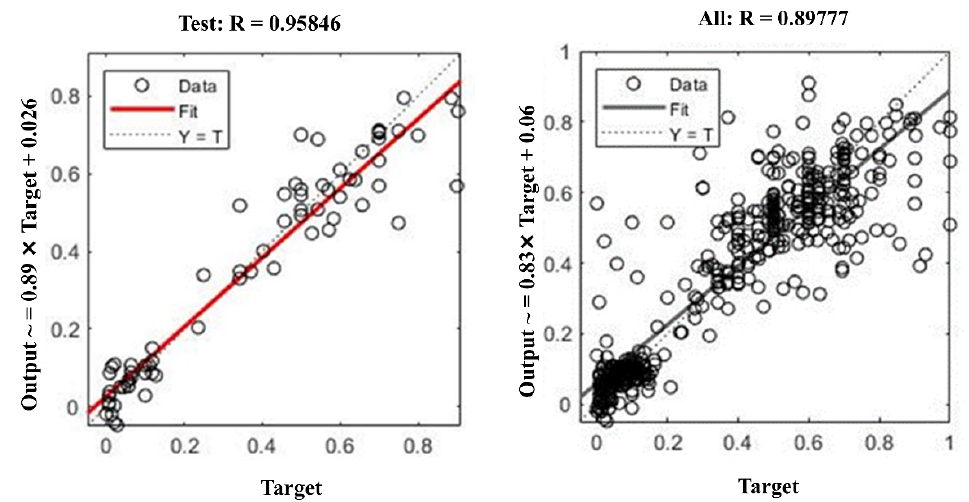
Figure 9. Diagrams of the best ANN result for each hyperspectral imaging mode.